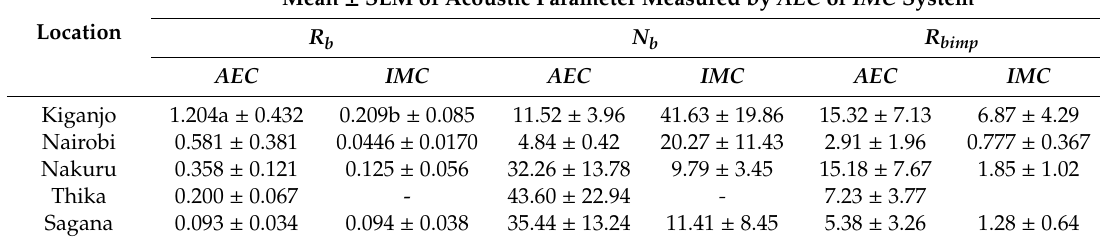
Table 2. Mean comparisons of burst rate, R b , impulses per burst, N b , and rates of impulses in bursts, R bimp , recorded by the AEC and IMC systems in bags at di ff erent warehouses. Lack of line current precluded use of the IMC system at Thika. Means of a given acoustic parameter obtained with di ff erent acoustic systems at the same warehouse that are followed by a di ff erent letter are significantly di ff erent from each other ( p > 0.05) under the Tukey–Kramer honest significant di ff erence (HSD) test.